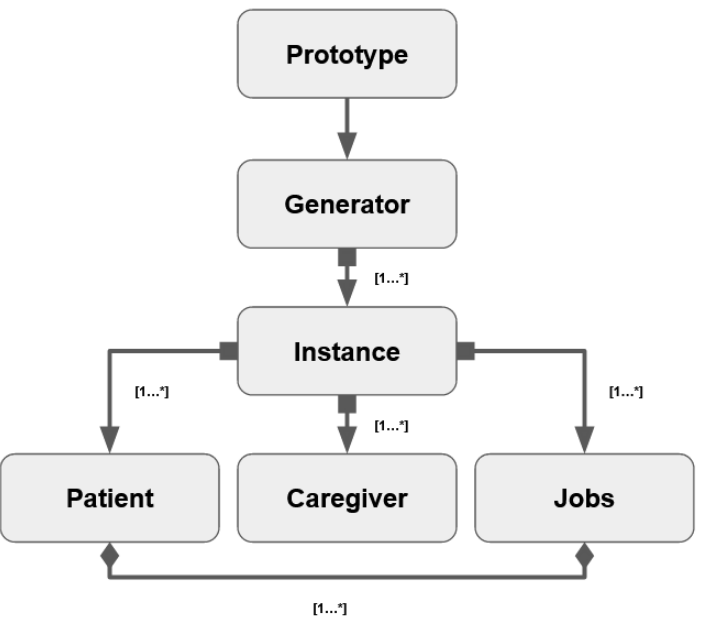
Figure 8. UML description of the generator. [ 1 . . . ∗ ] : one occurrence to multiple occurrences.